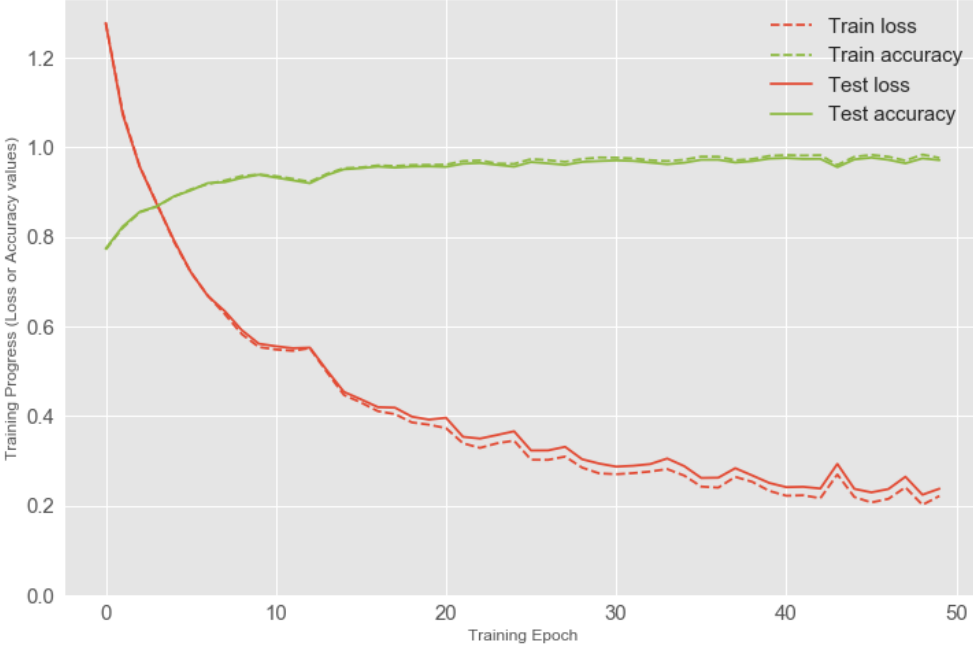
Figure 4. Training session’s progress over